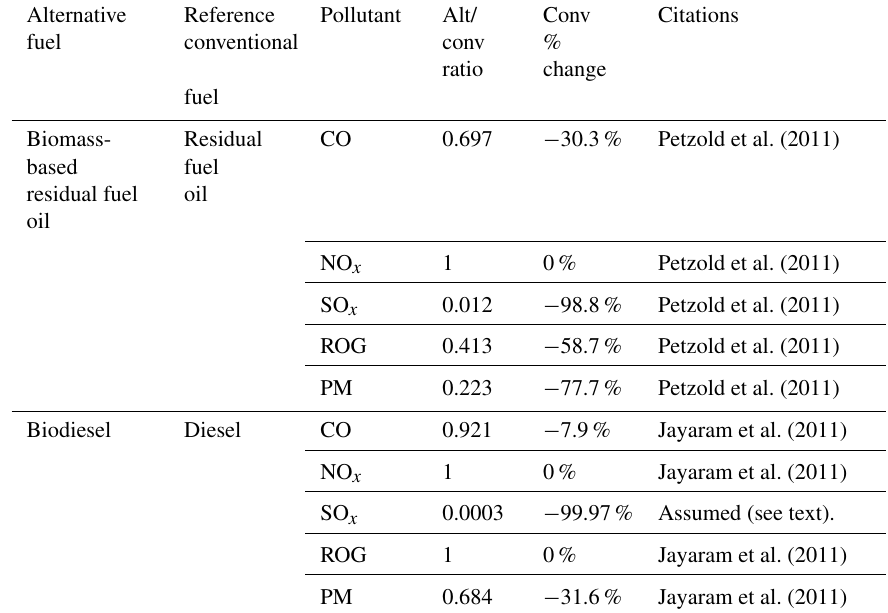
Table 3. Emissions rate changes from ships changing from conventional fuels to